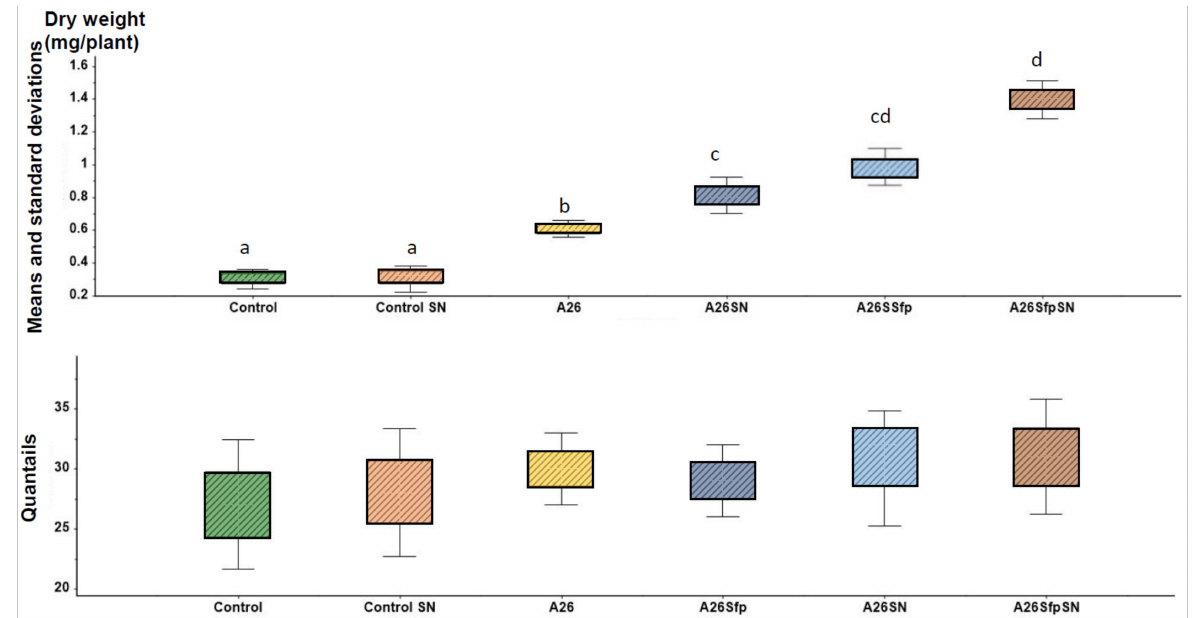
Figure 1. Seedlings weight analysis in soil assay. Plant dry weight means and standard deviations along box plot skewness of seedlings treated with A26, A26SN, A26Sfp, or A26SfpSN. ANOVA univariate analysis was performed and post hoc LSD tests were used to identify treatments significantly different from control ( p < 0.05). Different letters indicate statistically significant